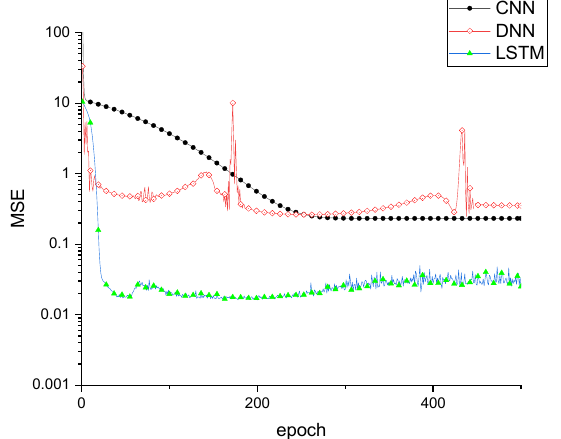
Figure 13. Comparison of the training losses of DNN, CNN, and LSTM models.